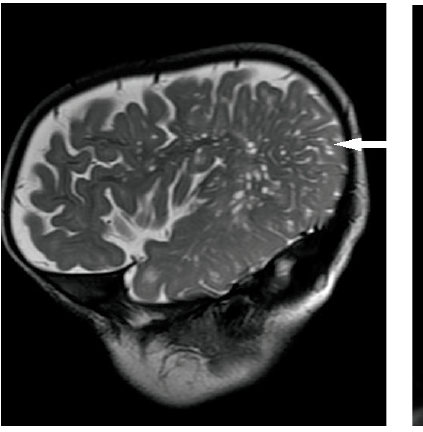
Fig. 5. Coronal T2 (TR/TE, 3260/101 ms) -weighted image shows the hydrocephalus with dilated lateral ventricles (black arrow) and 3rd ventricle (small arrow) with diffuse cerebral cortical atrophy and prominent cortical sulci (long arrow). Also seen is atrophied corpus callosum containing prominent perivascular space